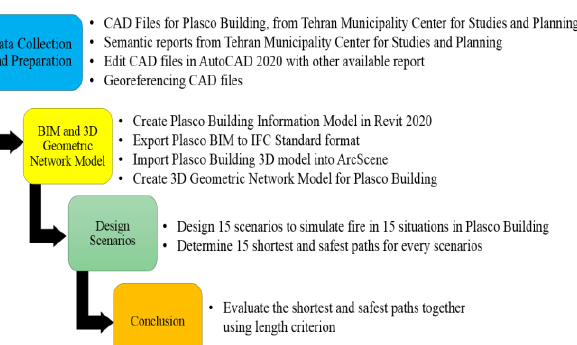
Figure 1. The Location of Plasco building